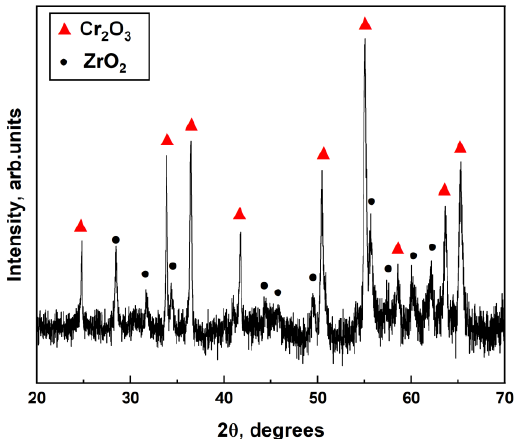
Figure 3. Diffraction pattern of the Cr/Mo-coated sample after oxidation at 1400 °C during 120 s.